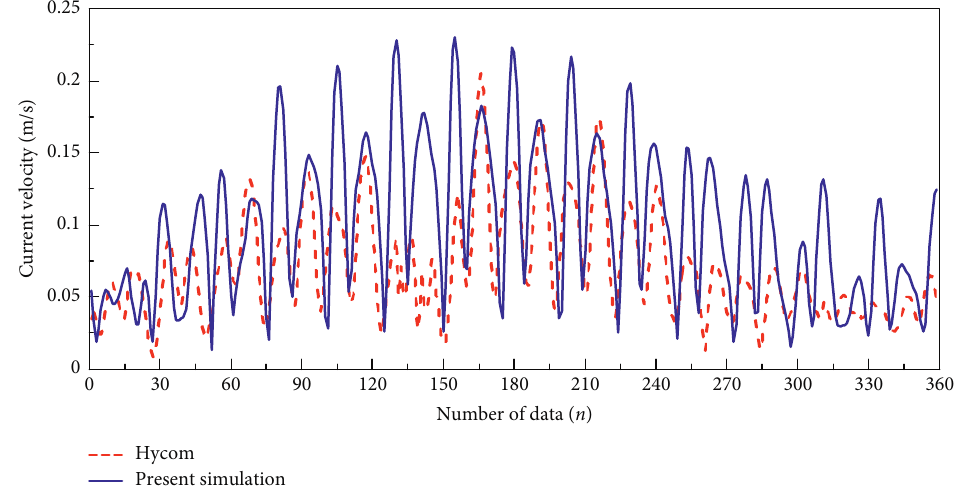
Figure 2: Current speed of Hycom versus present model (Mike 21).